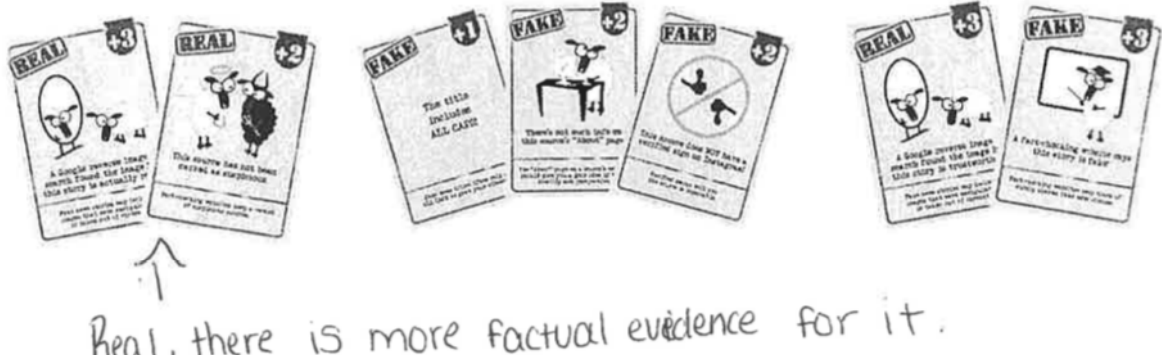
Figure 2 . A student response to a post-game reflection question asking which of the three hands of evidence is the strongest. While the middle hand should be considered the strongest, as it provides three different types of evidence instead of two, this student thought the first hand is strongest just because it contained evidence in support of a “real”